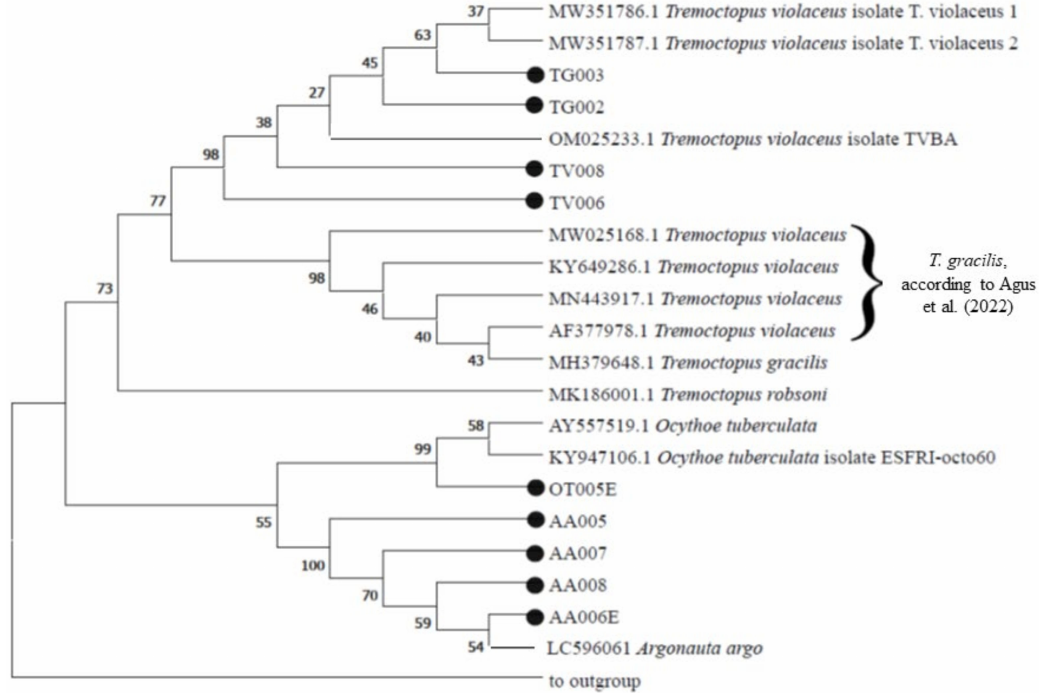
Figure 6. The phylogenetic tree was inferred using the Maximum Likelihood method and Kimura 2-parameter model [37]. The bootstrap consensus tree inferred from 1000 replicates is taken to represent the evolutionary history of the taxa analysed. The percentage of replicate trees in which the associated taxa clustered together in the bootstrap test (1000 replicates) are shown next to the branches. This analysis involved 22 nucleotide sequences. Sequences derived from a complete mitochondrial genome (NC_006353.1), attributed to the species Octopus vulgaris , was used as the outgroup, as reported in Agus et al.